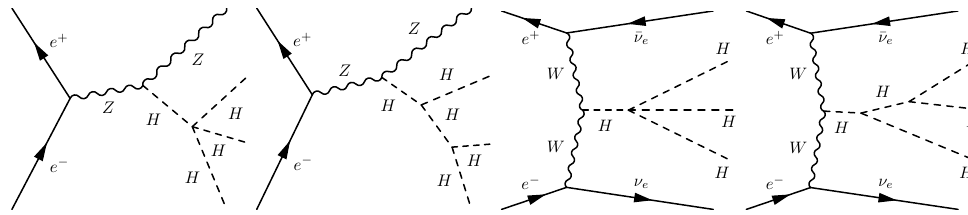
Figure 7 . Representative tree-level Feynman diagrams for triple Higgs